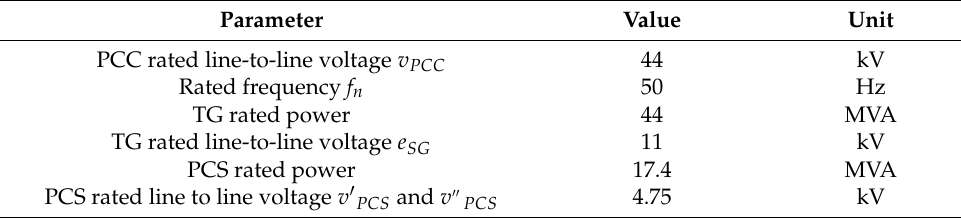
Table 1. Liquefied natural gas (LNG) plant electrical